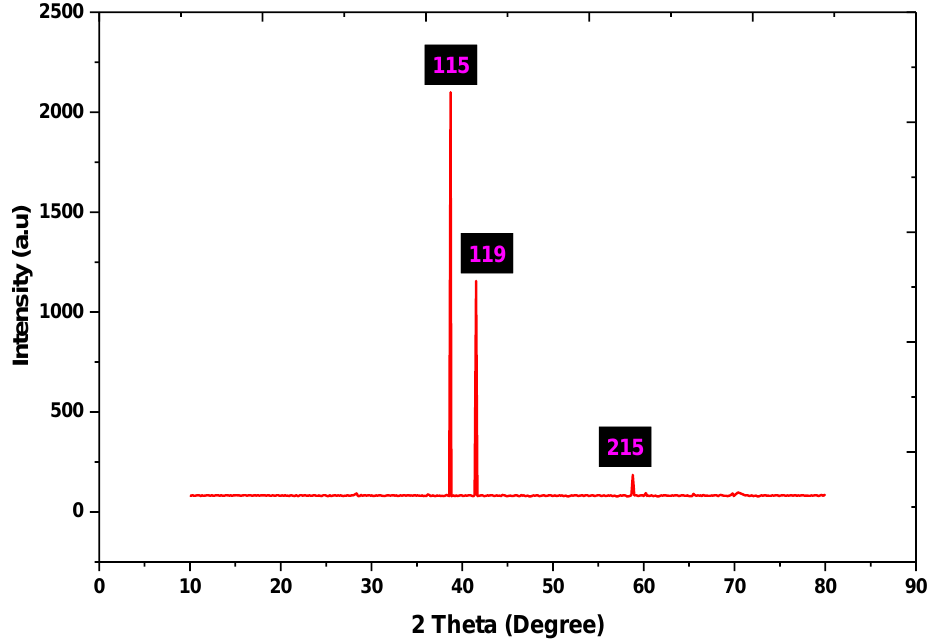
Figure 5. XRD patterns of Al 2 O 3 nanoparticles .